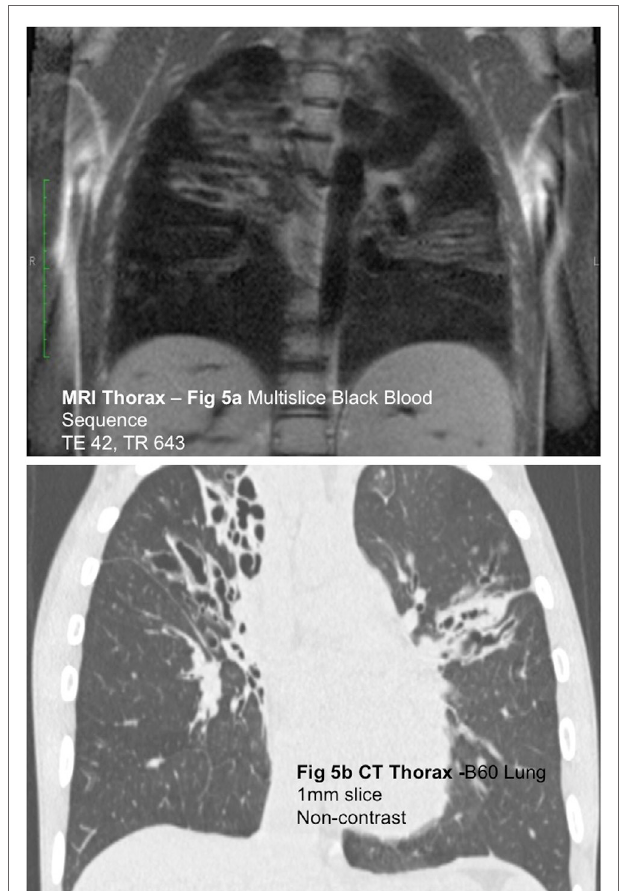
FigURe 5 | (A) Coronal black blood SSFP magnetic resonance (MR) image and (B) coronal computed tomography (CT) reconstruction in a child with cystic fibrosis. Although the spatial resolution of MRI is relatively poor compared to CT, MRI is capable of demonstrating gross airway